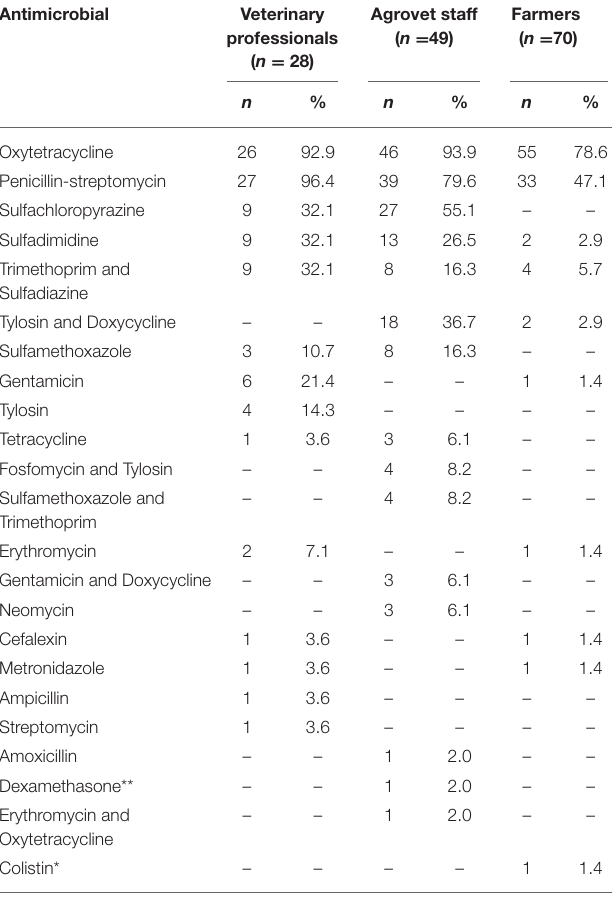
TABLE 2 | List of the most commonly used/purchased/prescribed antimicrobials according to farmers, agrovets, and veterinary professionals, to treat livestock.